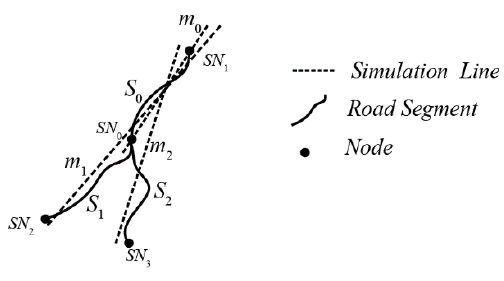
Figure 4. Diagrammatical rules for road connections.